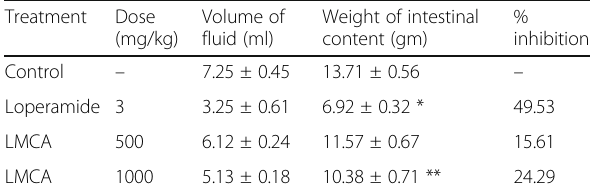
Table 8 Effect of leaf methanolic extract of LMCA in castor oil induced diarrhea in mice Group